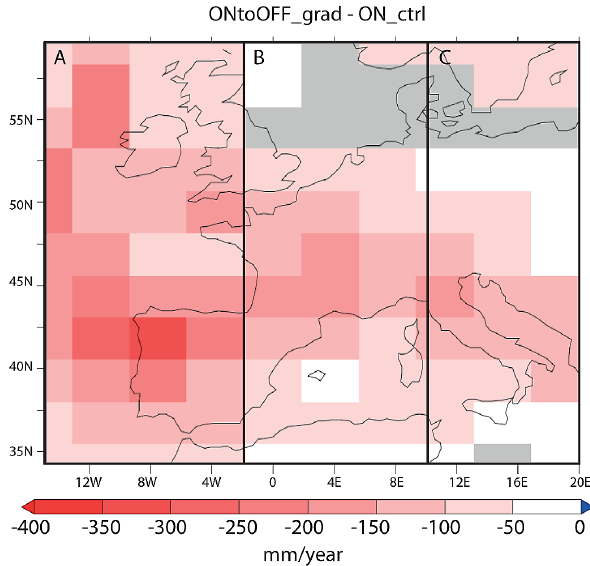
Fig. 8. Difference in annual precipitation (mm/year) between ON ctrl (average over 500yr) and the end of ONtoOFF grad (av- erage over the last 200yr of the run). Grey areas are points where the difference is not significant at the 95%